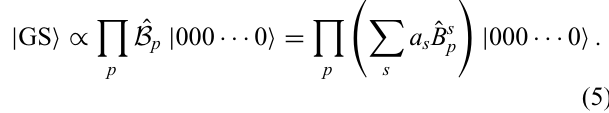
FIG. 2. The construction of the double-semion ground state. We implement the algorithm as an analogy to Fig. 1(c): the rep- resentative qubits (blue) are initialized in |−(cid:3) = ( | 0 (cid:3) − | 1 (cid:3) )/ and the rest of the qubits (red) are | 0 (cid:3) . (a) The construction con- sists of parallel application of C- ˆ B p on each row. (b) The circuit diagram for C- ˆ B p . The two-qubit gate symbolized by two solid dots connected by a line is a controlled- Z gate. The three-qubit gate applies ˆ σ z to the third qubit if the solid and hollow control qubits are 1 and 0, respectively; otherwise, it does nothing. The dashed box in the circuit diagram contains the unitary that gives a phase + 1 ( − 1) if the number of loops changes (unchanged) when a TC plaquette operator is applied [as shown in